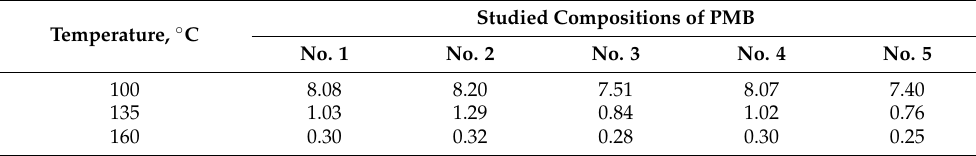
Table 8. Dynamic viscosity [Pa · s] of polymer-modified binder at a shear rate of 90 s − 1 . Studied Compositions of Temperature, ◦ C